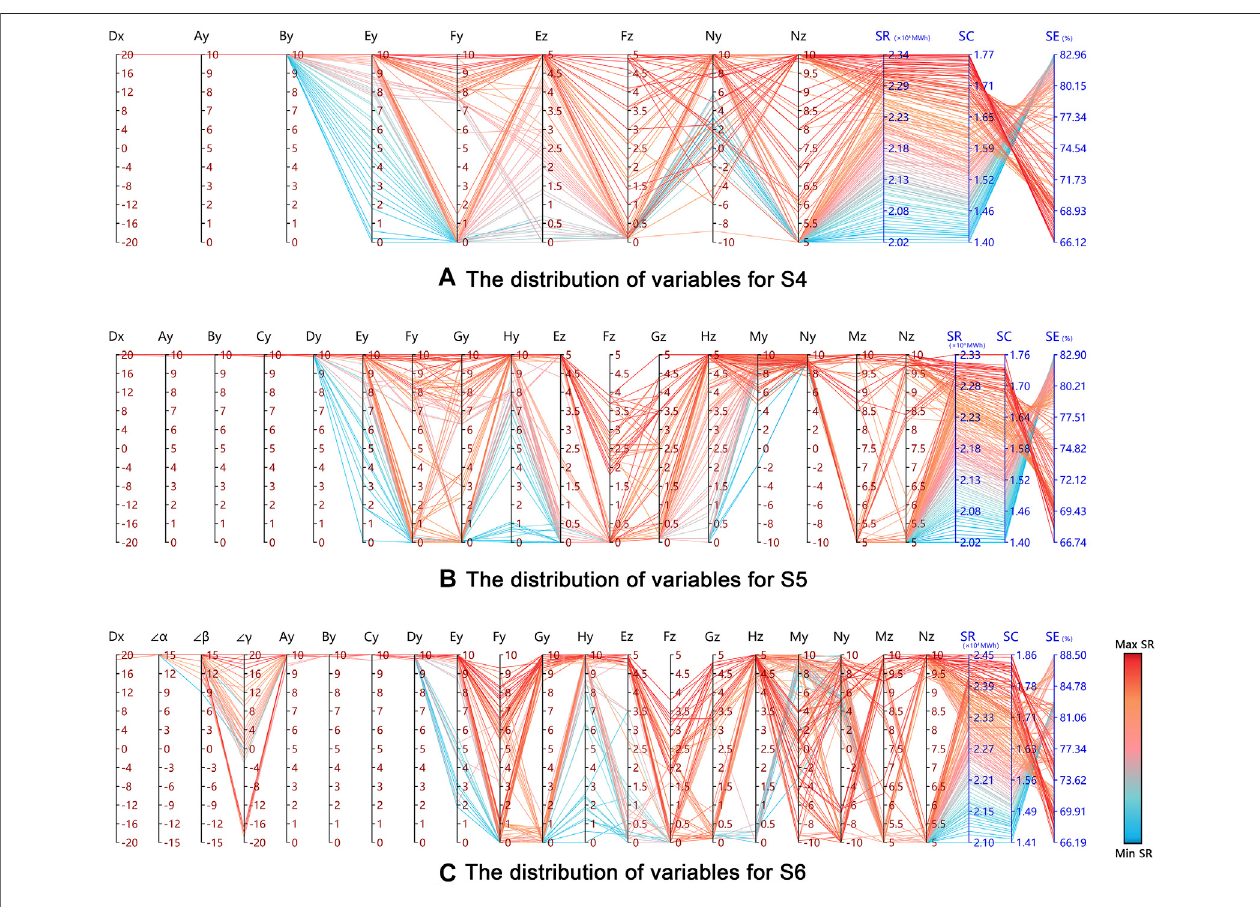
FIGURE 15 | Variable distributions of shapes S4-S6: (A) S4; (B) S5; (C)